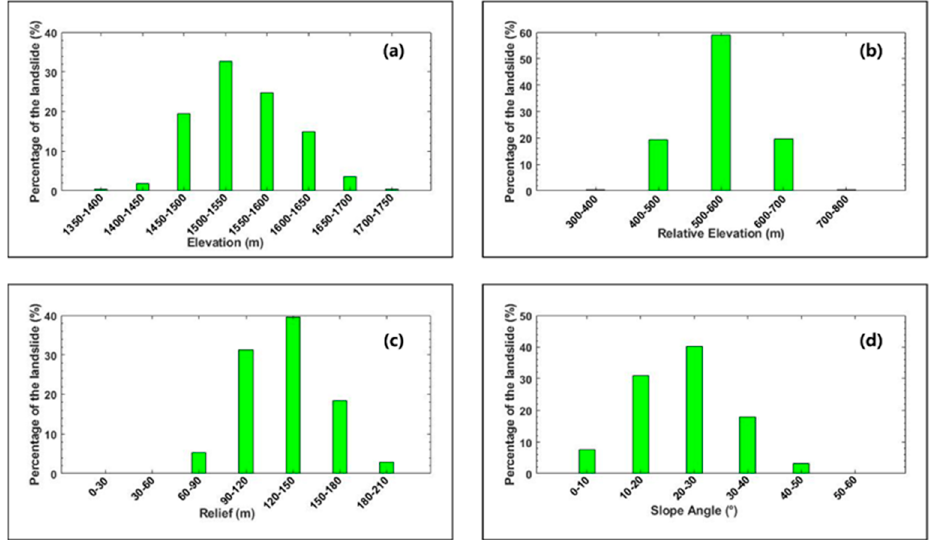
Figure 9. Statistics of landslide distribution versus ( a ) elevation; ( b ) relative elevation; ( c ) local topographic relief; and ( d ) slope angle.